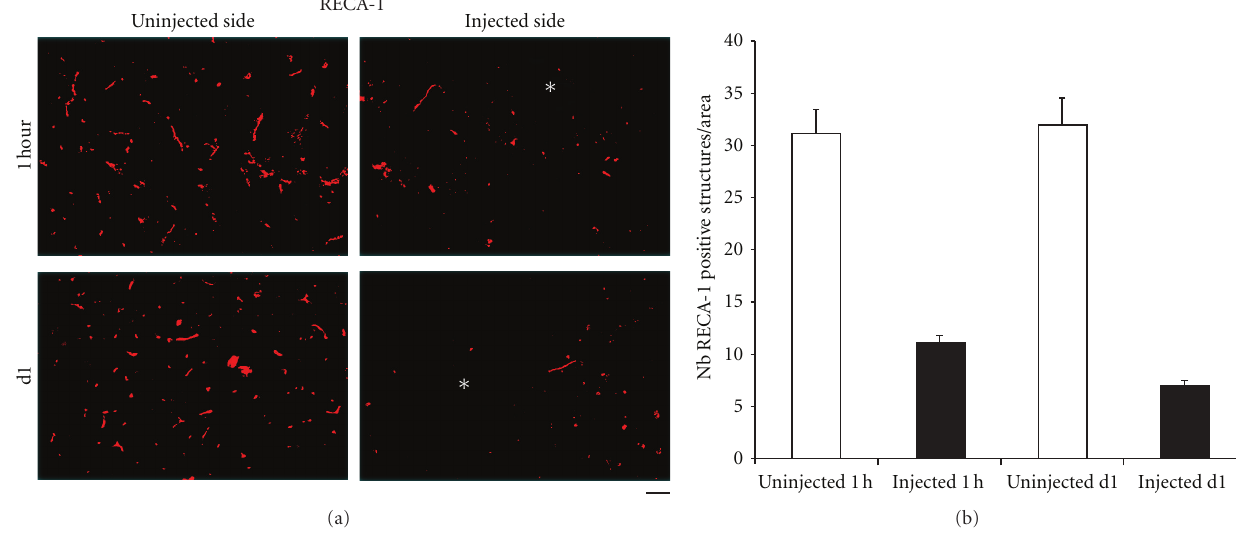
Figure 5: Reduction in the number of brain microvessels after gp120 injection. A decrease in the number of RECA-1-(a marker of microvessels) positive structures was seen after injection of 500ng gp120 into the rat CP. This e ff ect was observed as early at 1 hour after the injection. Bar: 60 μ m.